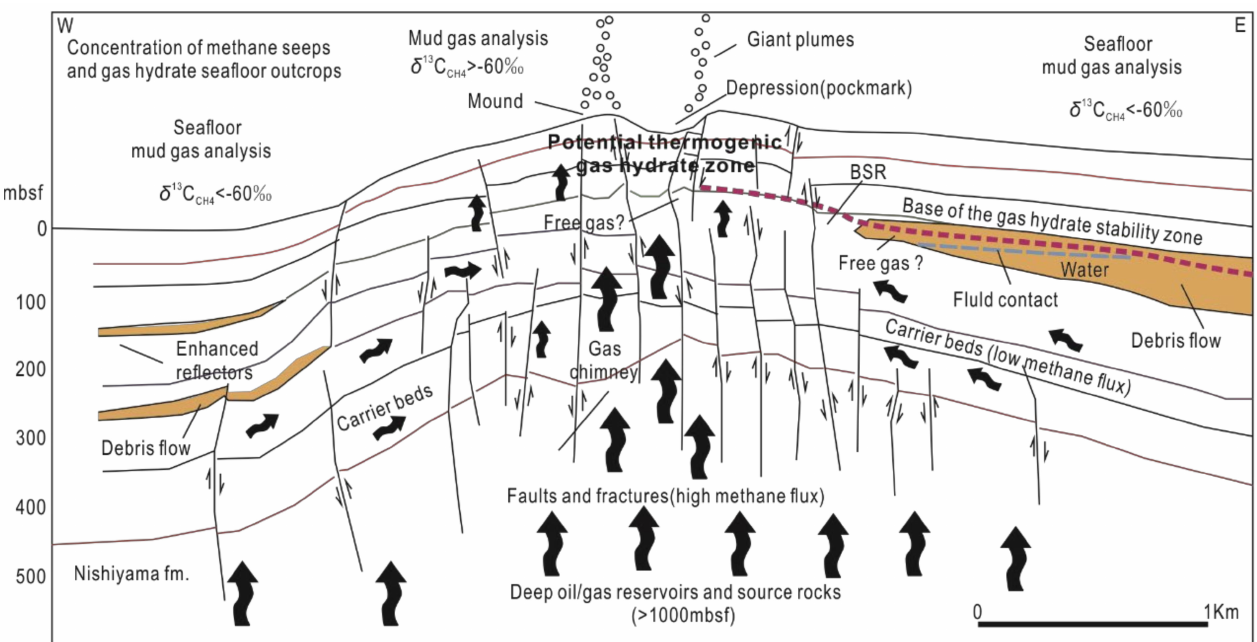
Figure 2. Structural and stratigraphic gas-focused model and shallow hydrate system for the Umitaka Spur. Note: Orange zones indicate debris flow deposits. Big black arrows represent the directions of gas migration. The size of these arrows represents the migration intensity (cited from